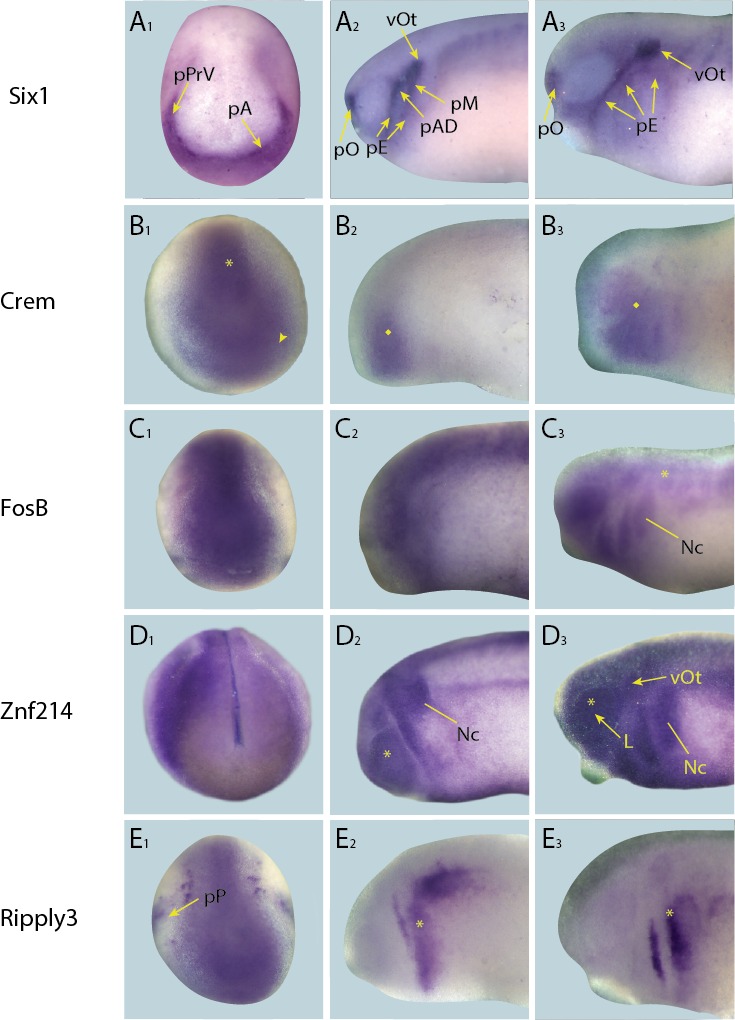
Expression of targets that broadly overlap with PPE in whole-mount Xenopus embryos.Expression dynamics for each target are shown across a range of developmental stages: A1–E1 show expression in neural plate stage embryos, A2–E2 show early tail bud stage embryos and A3–E3 show late tail bud stage embryos. (A) Expression of PPE marker gene Six1 is shown as reference for placodal domains (for details see Pandur and Moody, 2000; Schlosser and Ahrens, 2004). (B) Crem is initially expressed broadly in paraxial mesoderm (B1; asterisk) and cranial ectoderm (B1; arrowhead) at neural plate stages and in pharyngeal arches and overlying ectoderm at early and late tail bud stages (B2 and B3 ; diamond). (C) FosB is expressed in a broad pattern across the cranial ectoderm and trunk mesoderm at both neural fold and early tail bud stages (C1and C2). At late tail bud stages expression is maintained in cranial ectoderm as well as becoming apparent in the migrating neural crest cells (Nc) and weakly in the somites (C3; arrowhead). (D) Znf214 is expressed broadly across the ectoderm at all developmental stages (D1–D3). At both early and late tail bud stages there is expression in the migrating neural crest cells (Nc) as well as in the retina (D2 and D3; asterisk), and in late tail bud stages Znf214 is expressed in the otic vesicle and lens. (E) Ripply3 is expressed broadly in the posterior placodal region at neural fold stages (E1). At both early and late tail bud stages expression is confined to posterior cranial ectoderm (E2 and E3; asterisk). Yellow arrows mark placodal expression. Abbreviations: pA: anterior placodal region; pAD: anterior lateral line placode; pE: epibranchial placode; L: lens; pM: middle lateral line placode; pO: olfactory placode; vOt: otic vesicle; pP: posterior placodal region; pPrV: profundal/trigeminal placodes.